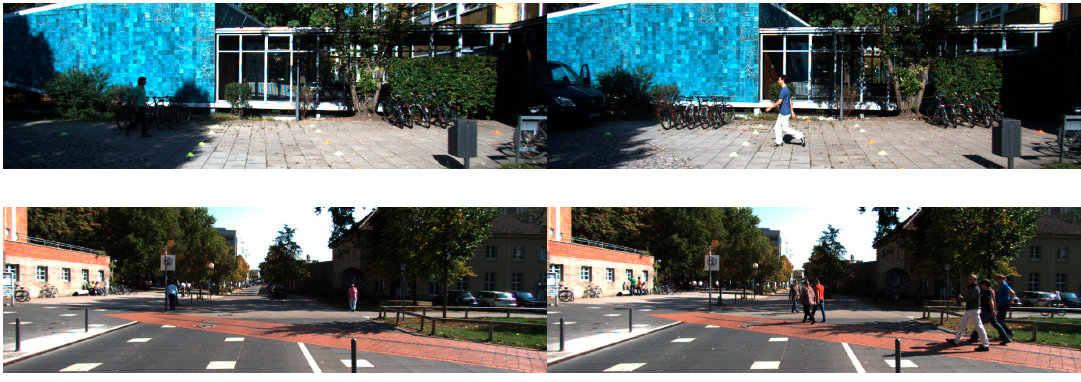
Figure 8. Two groups of images from KITTI.